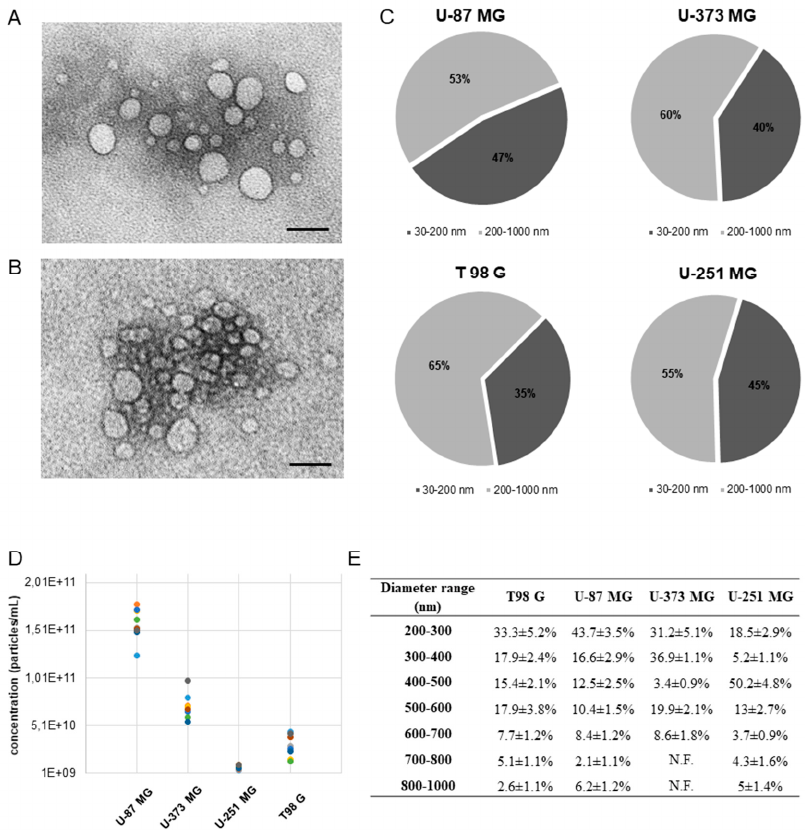
Figure 1. Characterization of EVs concentrated from U-87 MG, U-373 MG, T 98G, and U-251 MG